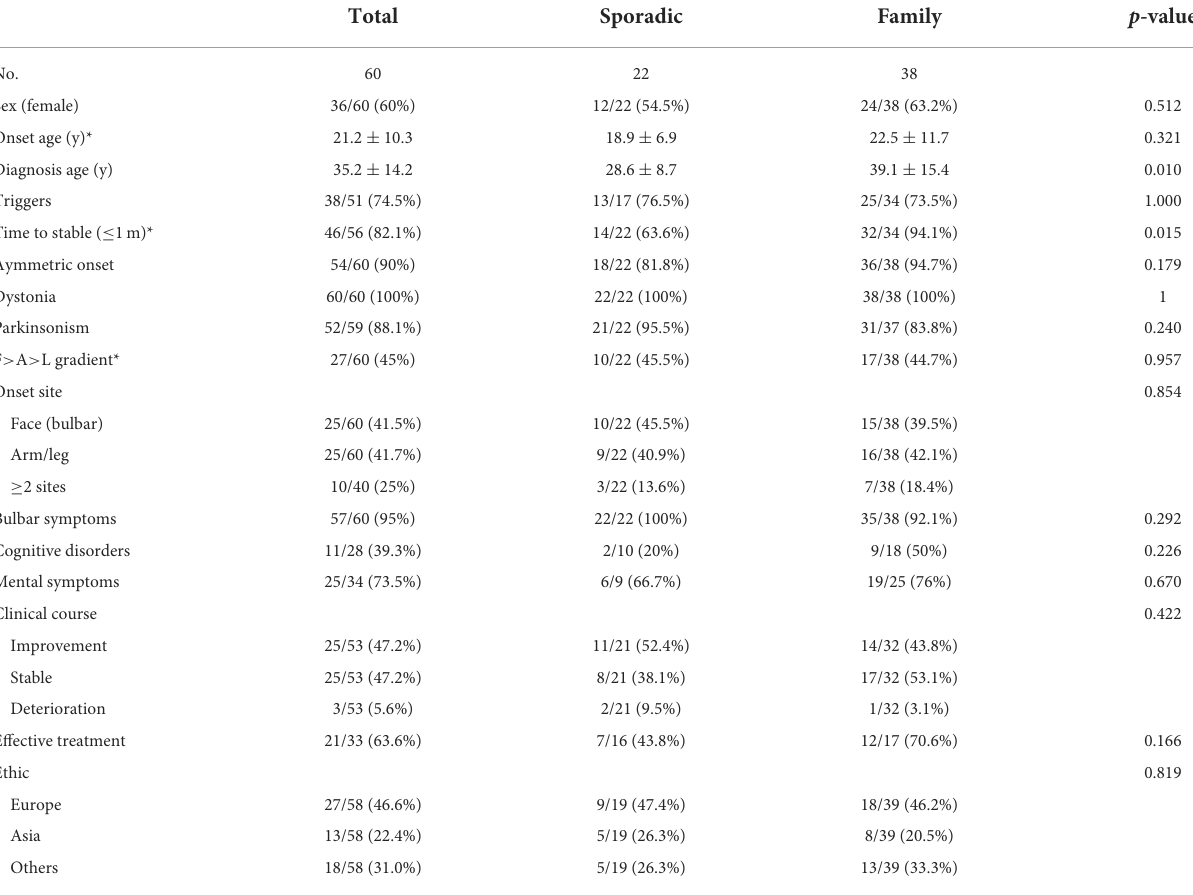
TABLE 1 Clinical characteristics of ATP1A3 -related